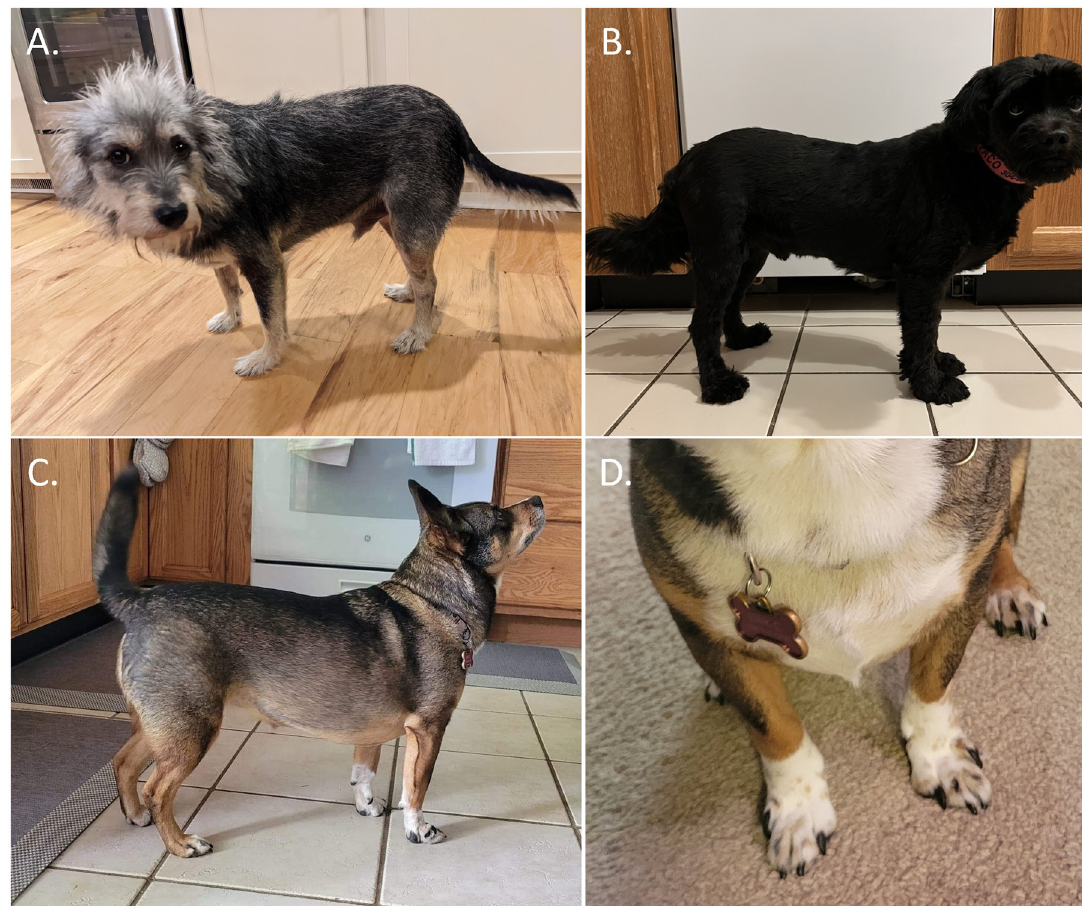
Fig 4. Disproportionate dwarfism phenotypes in mixed breed dogs. A) Skeletal dysplasia 2 (SD2) manifests as a mild phenotype in which the front legs are typically shorter than the hind legs and the body and head are of normal size. B-C) ITGA10 gene-related disproportionate short-limbed chondrodysplasia manifests as shortened, typically crooked legs with a normal sized head and body and in some cases like D) also as abnormally short outer digits. (Table 1) and presence in 89 of the examined breeds or breed varieties at a frequency � 1% (S3 Table and [28]).